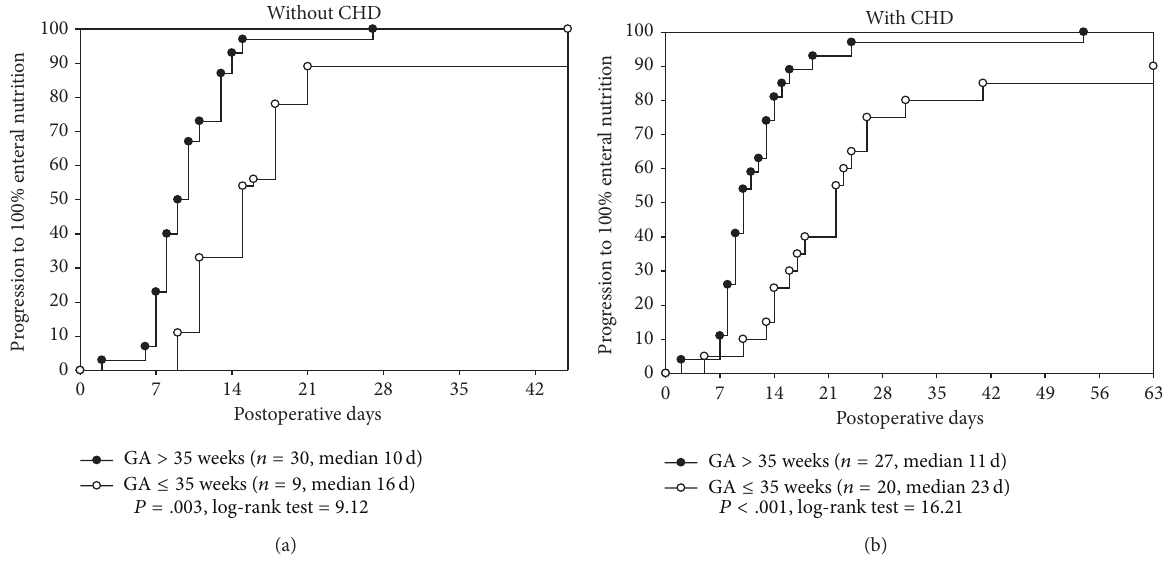
Figure1:(a)Kaplan-Meiercurvesillustratingtheprogressionto100%enteralnutrition(100%EN)inpatientswithoutcongenitalheartdisease (CHD). The importance of low gestational age (GA) is that if a patient was GA > 35 weeks ( 𝑛 = 30 ) then the median time to progression was 10 days (IQR: 8–12 days). However, if the GA ≤ 35 weeks ( 𝑛 = 9 ) then the median time to progression was 16 days (IQR: 11–20 days) ( 𝑃 = .003 , log-rank test = 9.12). (b) Kaplan-Meier curves illustrating the progression to 100% enteral nutrition (EN) in patients with congenital heart disease (CHD) and illustrates the synergistic effect of CHD on prematurity. For those patients with GA > 35 weeks ( 𝑛 = 27 ) and CHD, the median time to progression was 11 days (IQR: 8–14 days). For those patients with GA ≤ 35 weeks ( 𝑛 = 20 ) and CHD, their median time to progression was 23 days (IQR: 15–30 days) ( 𝑃 < .001 , log-rank test = 16.21). Both prematurity and the presence of CHD translated into a much longer delay in progression to 100%